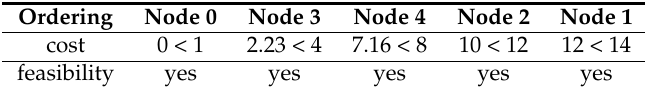
Table 7. A feasible solution for the network G 2